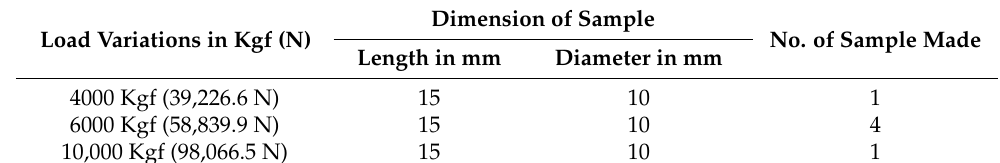
Table 1. Sample preparation using different loads.